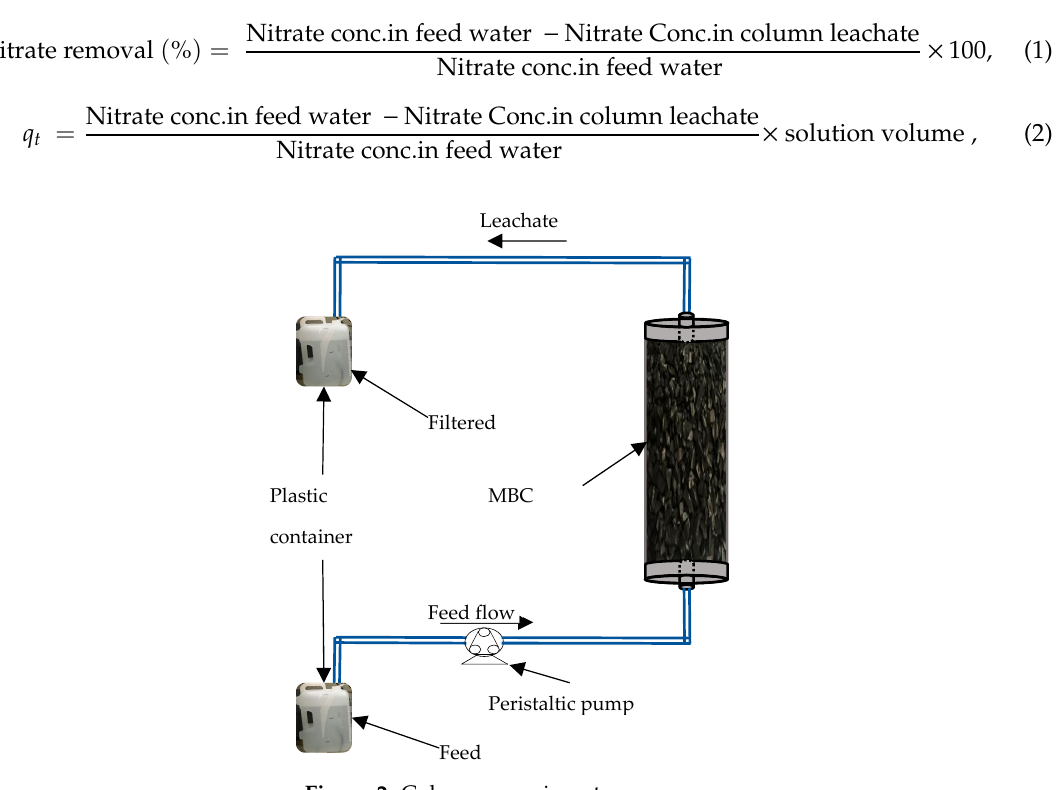
Figure 2. Column experiments process.